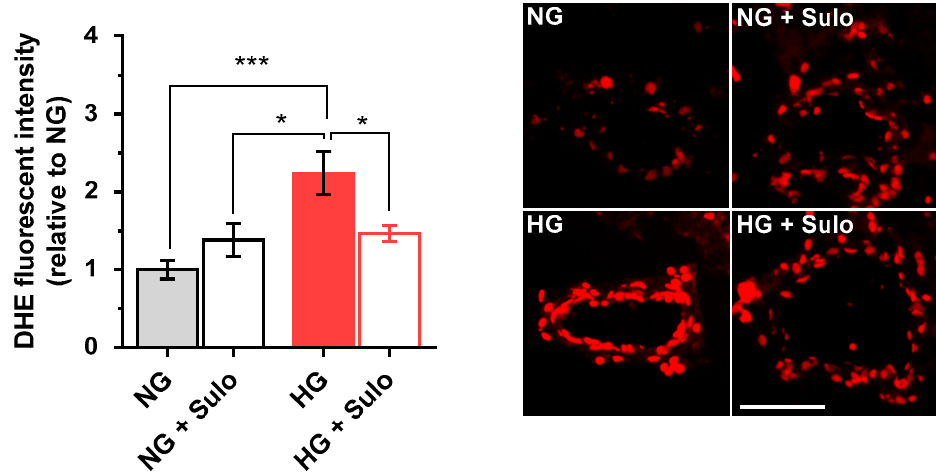
Figure 3. DHE staining of retinal arterioles in cryosections after two hours of incubation with HG (highly concentrated glucose solution; 25 mM D-glucose), HG + Sulo 50 µ g/mL (highly concentrated glucose solution + 50 µ g/mL sulodexide), NG (normally concentrated glucose solution; 5.5 mM D-glucose), and NG + Sulo 50 µ g/mL (NG + 50 µ g/mL sulodexide). The microphotographs show representative stainings of retinal arteriole cross-sections for the individual groups. Data are expressed as mean ± SE ( n = 8 per group; * p < 0.05, *** p < 0.001). Scale bar = 50 µ